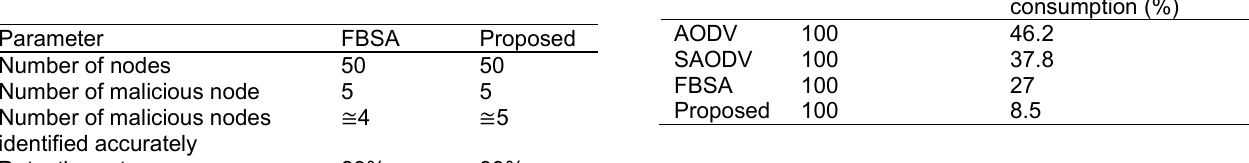
Table 5. Analysis on malicious node detection